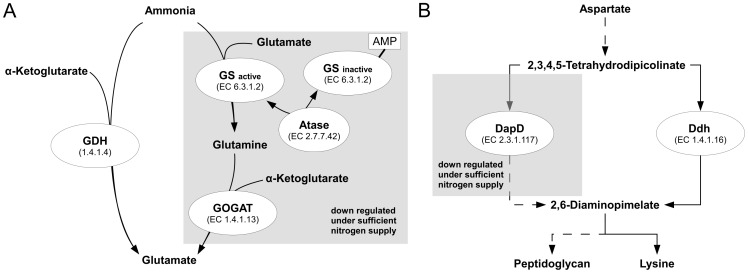
Schematic overview of the GS/GOGAT pathway (A) and the diaminopimelate biosynthesis (B).GDH: glutamate dehydrogenase; GS: glutamate-ammonia ligase; GOGAT: glutamate synthase; Atase: glutamate-ammonia ligase adenylyltransferase; DapD: tetrahydrodipicolinate succinylase; Ddh: diaminopimelate dehydrogenase. Dashed arrows represent more than one reaction.